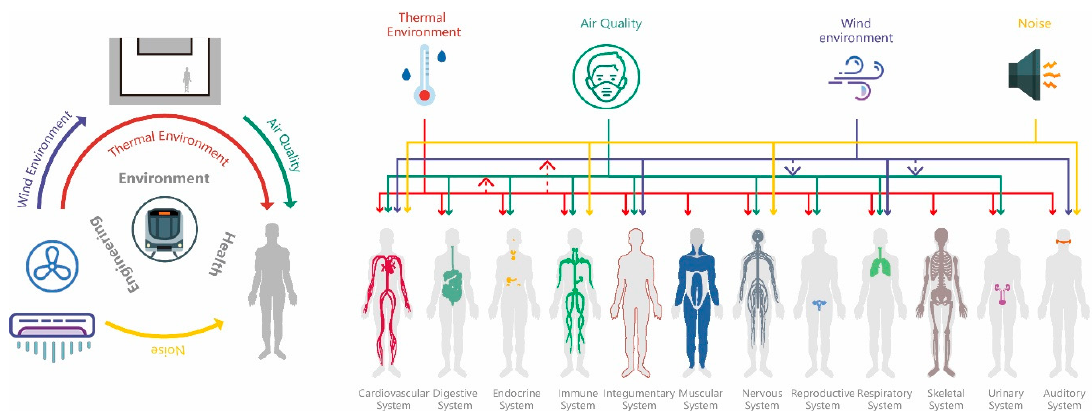
Figure 2. Mechanism of subway ventilation effects on environmental health.